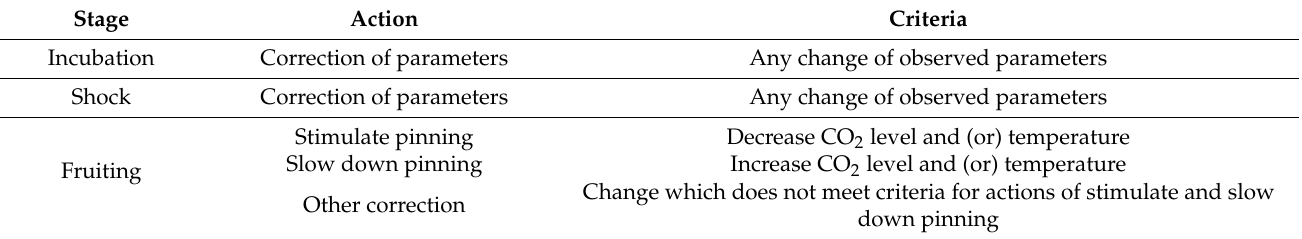
Table 2. Criteria to identify actions in different stages of production